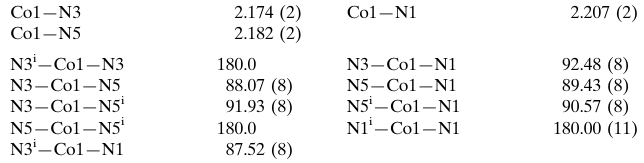
Selected geometric parameters (A˚ , (cid:2) ).